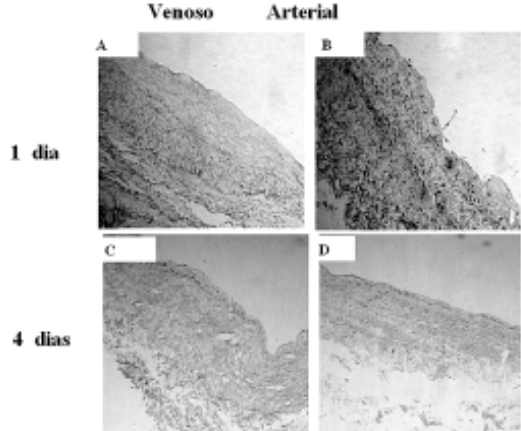
Fig. 7 - Ensaio de TUNEL para estudo de apoptose celular em veias safenas cultivadas por um (A,B) e quatro (C,D) dias, sob regime hemodinâmico venoso (A,C) e arterial (B,D) (aumento de 100X).Somente as veias cultivadas sob regime arterial